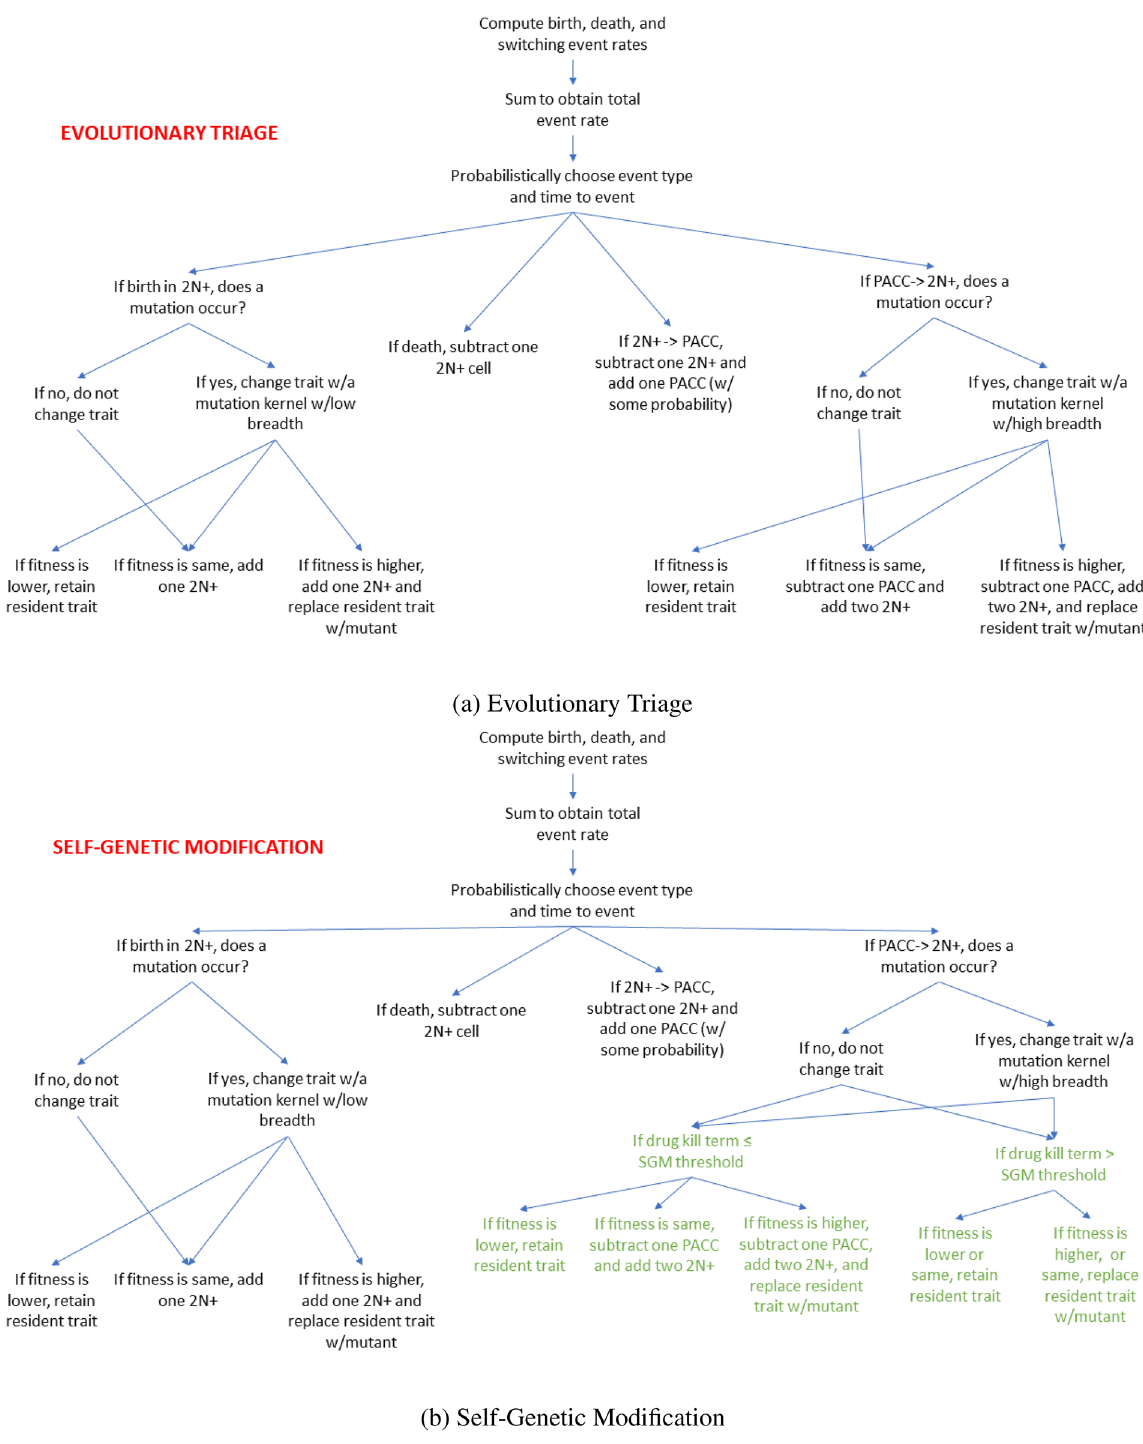
Figure 1. Flowcharts depicting the probabilistic and hence stochastic steps for the simulations of evolutionary triage ( a ) and self-genetic modification ( b ). The green text indicates where in the simulation process SGM differs from ET. See the Supplemental Material for a thorough explanation for how Eq. (1) translates into the stochastic birth–death switching